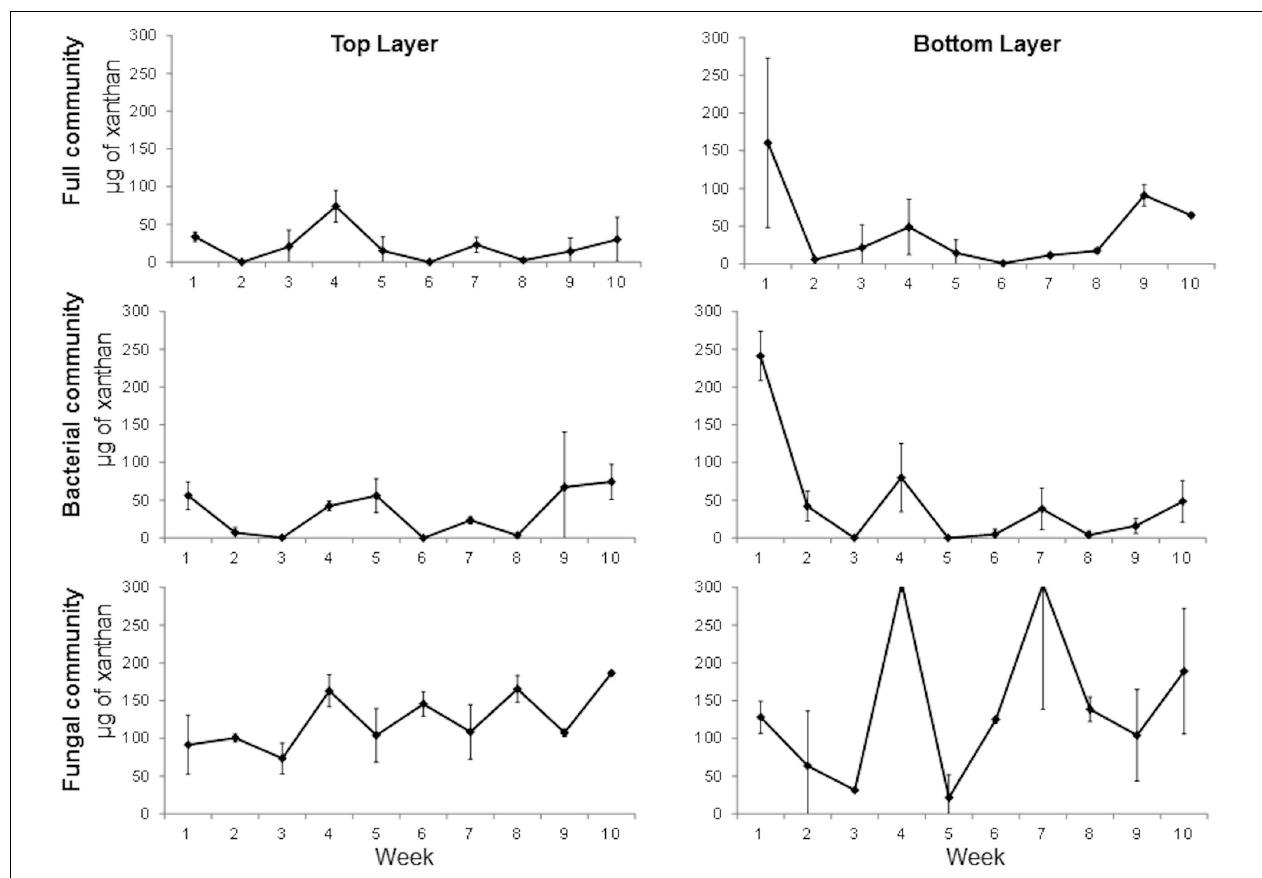
FIGURE 4 |Time series of xanthan concentration in full, bacterial, and fungal communities’ enrichments from top and bottom layers of a mature microbial mat during the wet season. Error bars represent the standard deviation of the